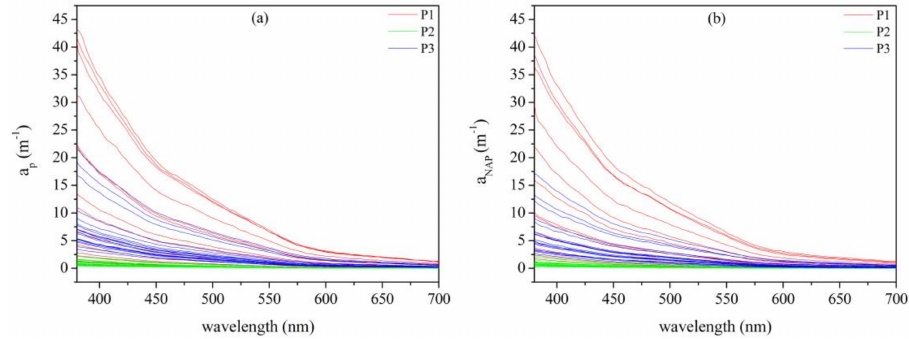
Figure 7. Spectral curves of: total particle absorption ( a ); and non-algal particle absorption ( b ), at Stations P1 (red lines, N = 16), P2 (green lines, N = 22) and P3 (blue lines, N = 18). Note that the magnitude of the spectral absorption coefficient for total particles was nearly similar to that for non-algal particles.